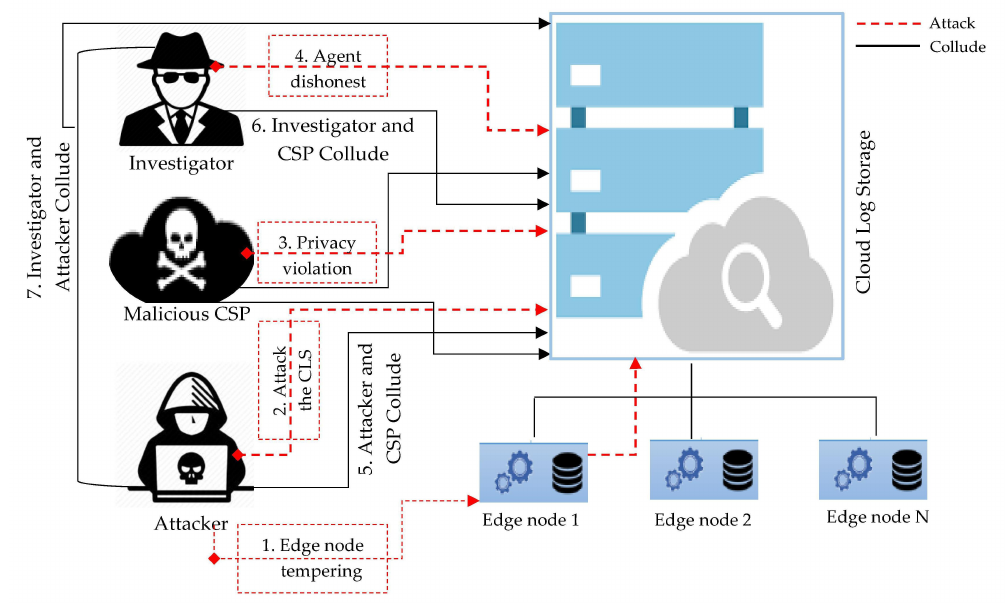
Figure 2. Threat